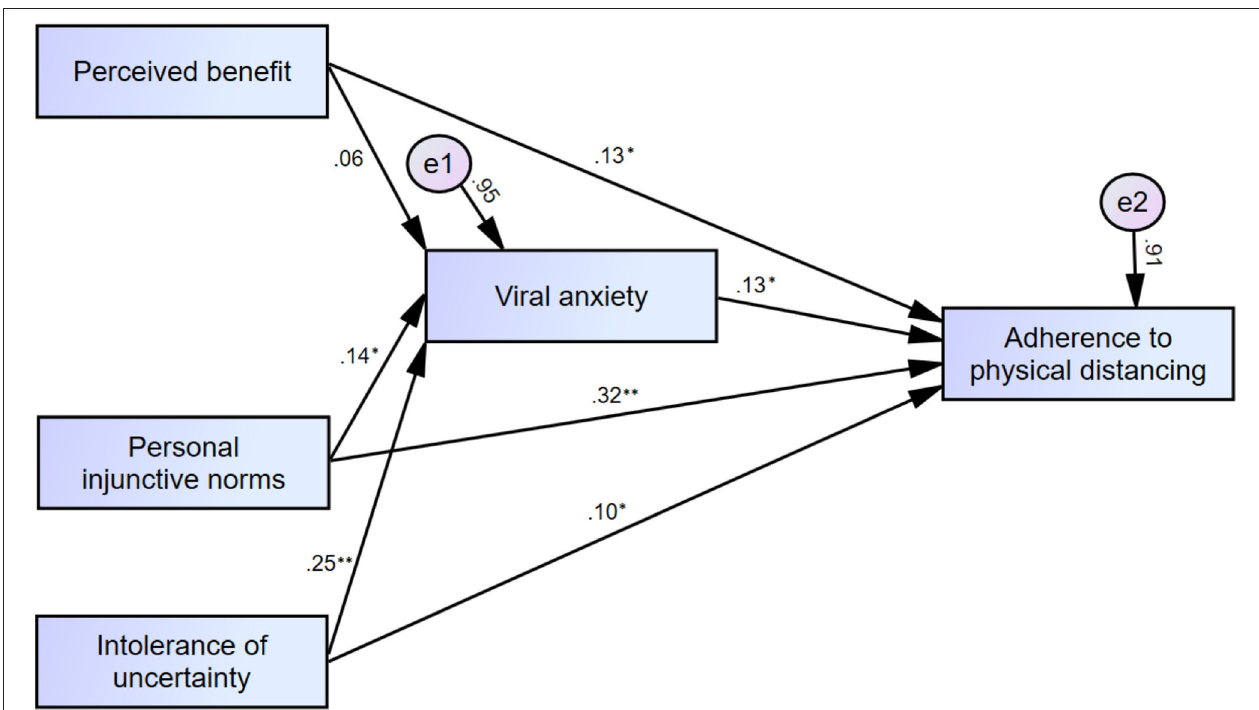
FIGURE 1 | Mediation model showing the pathway from the effect of perceived benefits, personal injunctive norms, and intolerance of uncertainty (independent variables) on adherence to physical distancing (outcome) through viral anxiety (mediator). * p < 0.05, ** p <